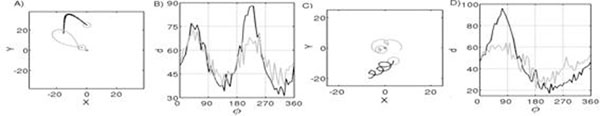
A and C: two trajectories (black and gray) of the agent's behaviour (circle is the agent's body at the end of each trajectory; light source is positioned at X=0; Y=0). B and D: show the existence of different dynamical regimes of phase relation for each trajectory (black and gray); ϕ (x-axis) is the phase relation and d (y-axis) is the phase density within the time interval of each trajectory. B characterizes 2 different phase regimes which mainly differ by a greater tendency of the black one (which is related to the black trajectory in A) to be within [180, 270]. D characterizes 2 different phase regimes which mainly differ by a greater tendency of the black one (which is related to the black trajectory in C) to be within [70, 90].